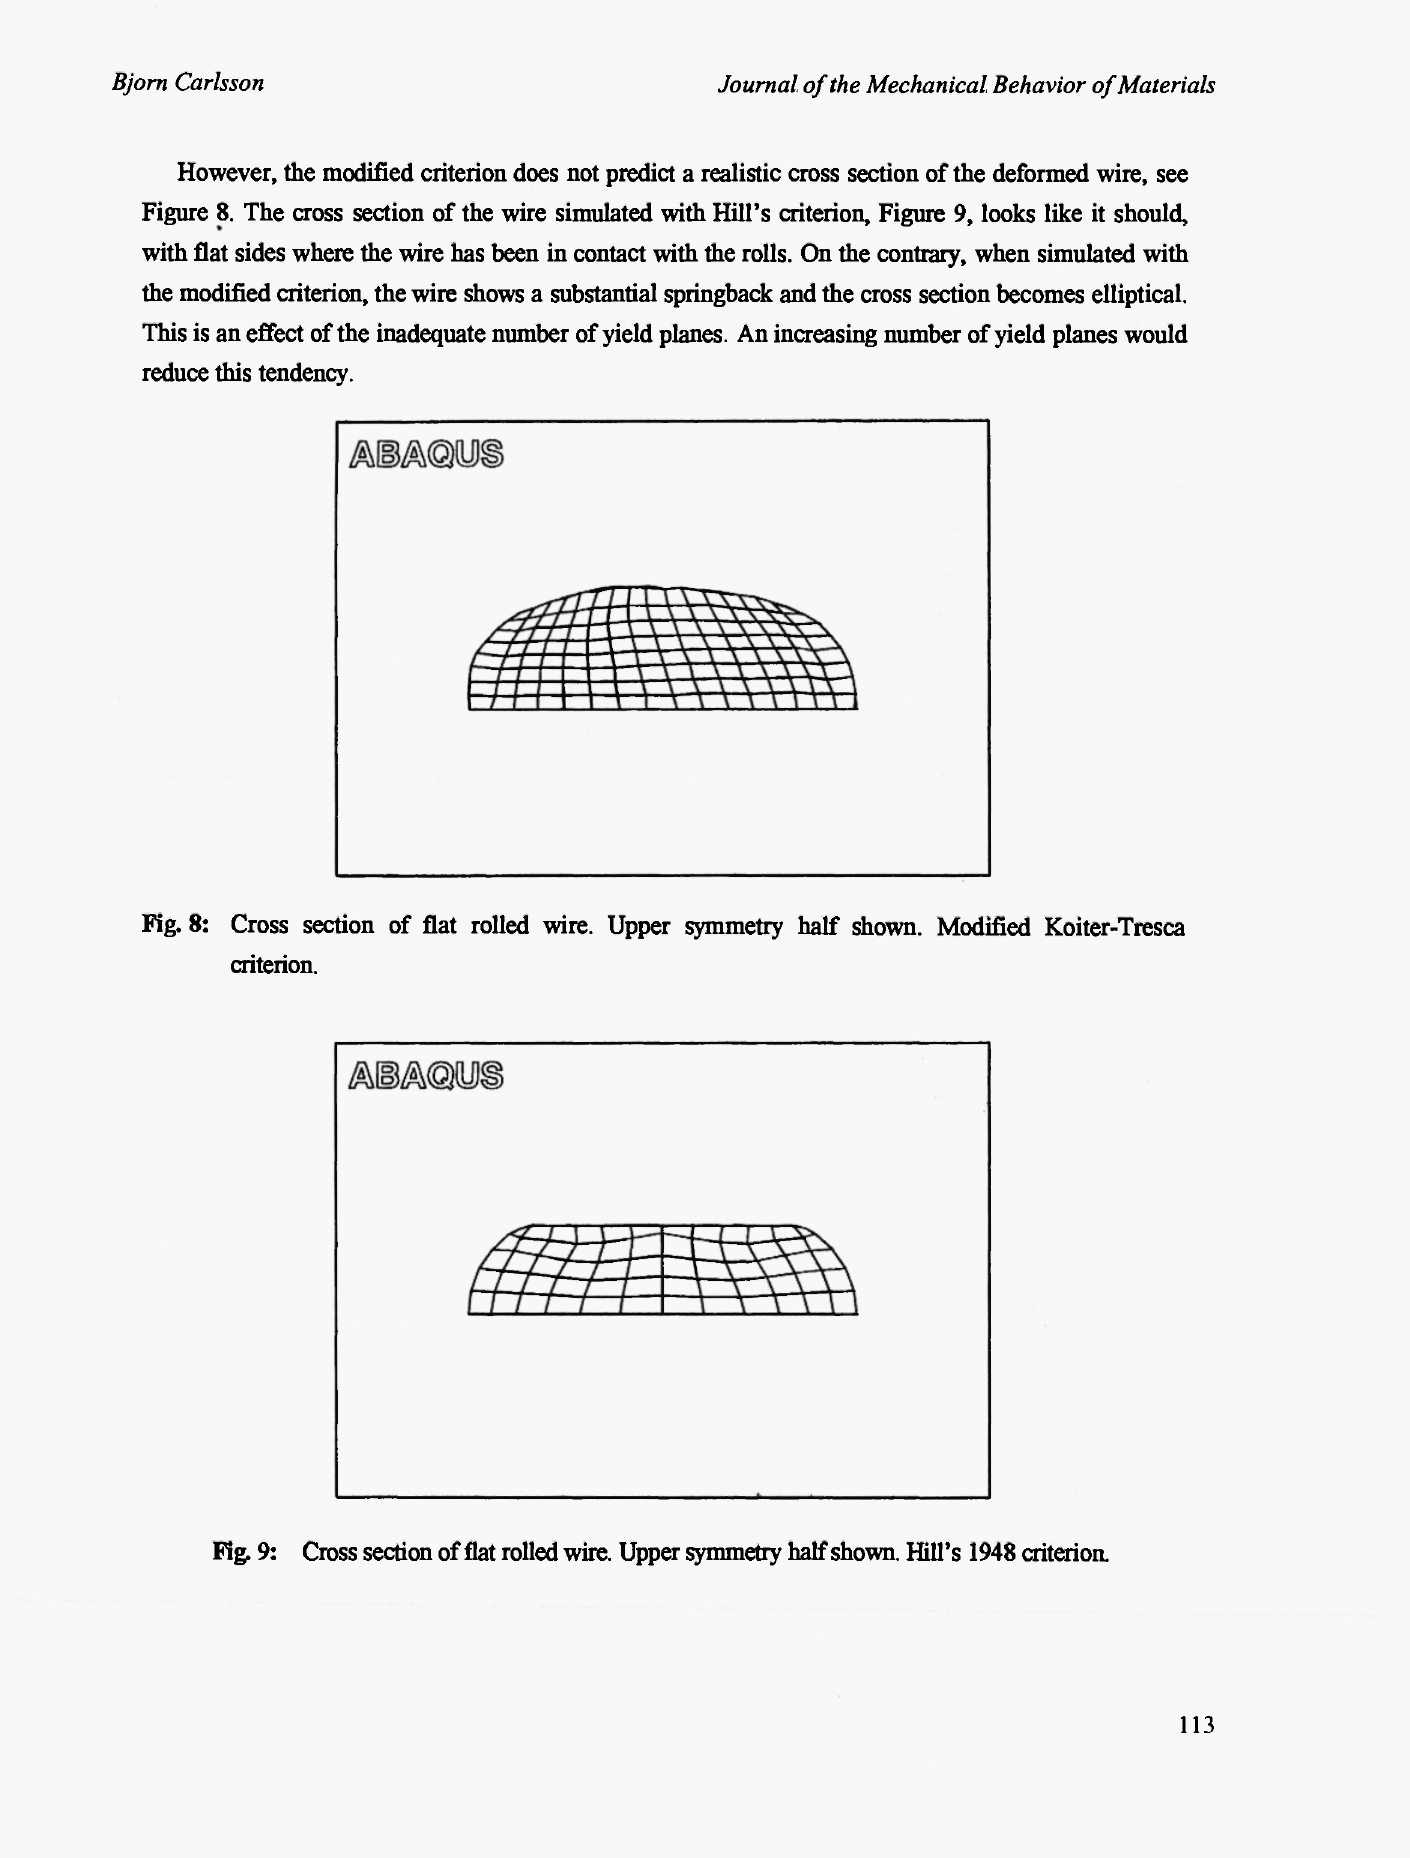
Fig. 9: Cross section of flat rolled wire. Upper symmetry half shown. Hill's 1948